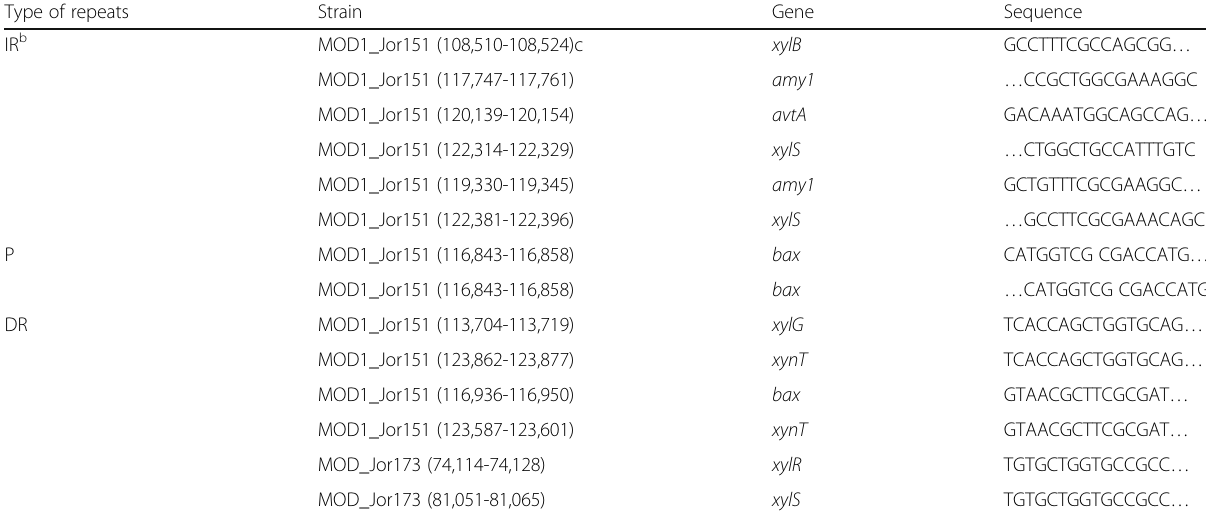
Table 7 Summary of inverted repeat, palindrome, and direct repeat present in C. sakazakii strains MOD1_Jor151 and MOD1_Jor173 genomes